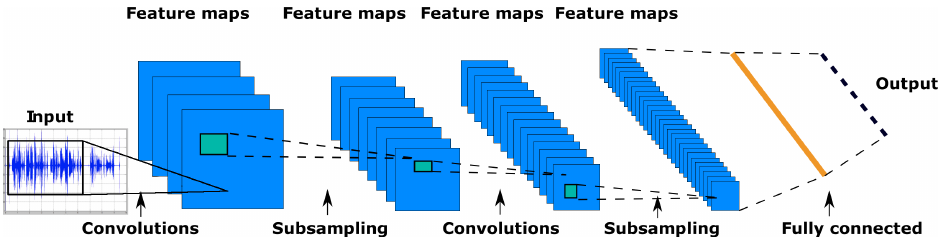
Figure 4. Typical CNN